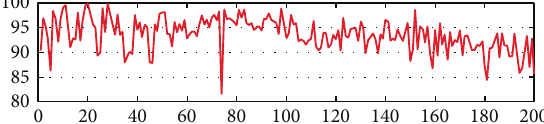
Figure 8: This graph illustrates the accuracy of the Helix bearing algorithm estimating 200 samples of perfect 95 degree turns (cali- brated with a digital protractor) performed at various locations with increasing clutter, at random angular rates not exceeding 1 radian- per-second, in the absence of known